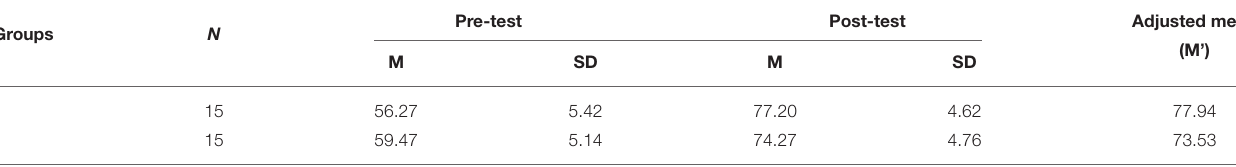
TABLE 1 | Summary of descriptive statistics analysis. Groups